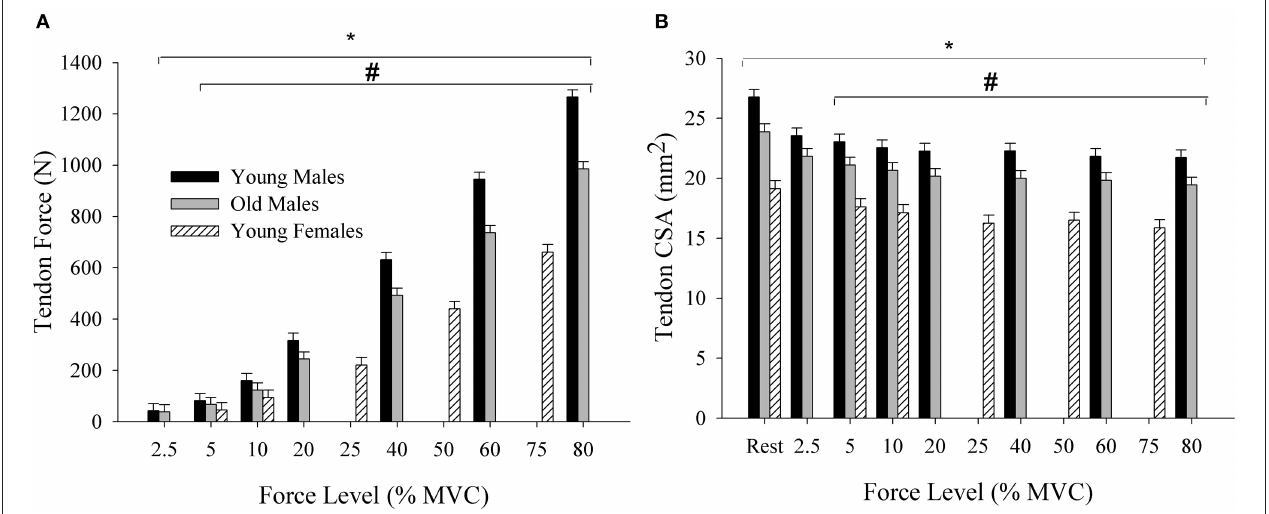
FIGURE 4 | (A) Tendon force across the submaximal force levels for young and old males and young females. Tendon force increased with the contraction intensity and was greater in young males compared with the old males and young females. (B) Tendon CSA at rest and across the submaximal force levels. CSA, cross-sectional area; MVC, Maximal voluntary contraction; N, Newtons. *differs across force levels; # differs between all the three groups at 5% and 10% MVC, and between young and old males at 20, 40, 60, and 80% MVC ( p <